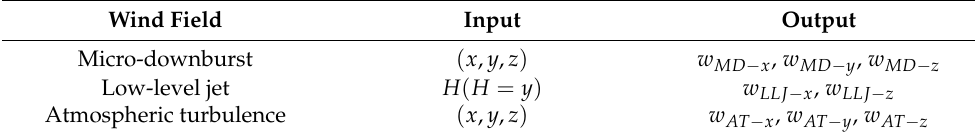
Table 4. Input and output parameters of the three typical wind field models established. Wind Field